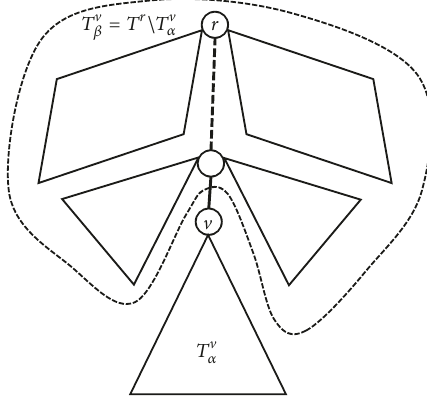
Figure 1: The decomposition of the rooted tree 𝑇 𝑟 at node V into two subtrees 𝑇 V 𝛼 and 𝑇 V 𝛽